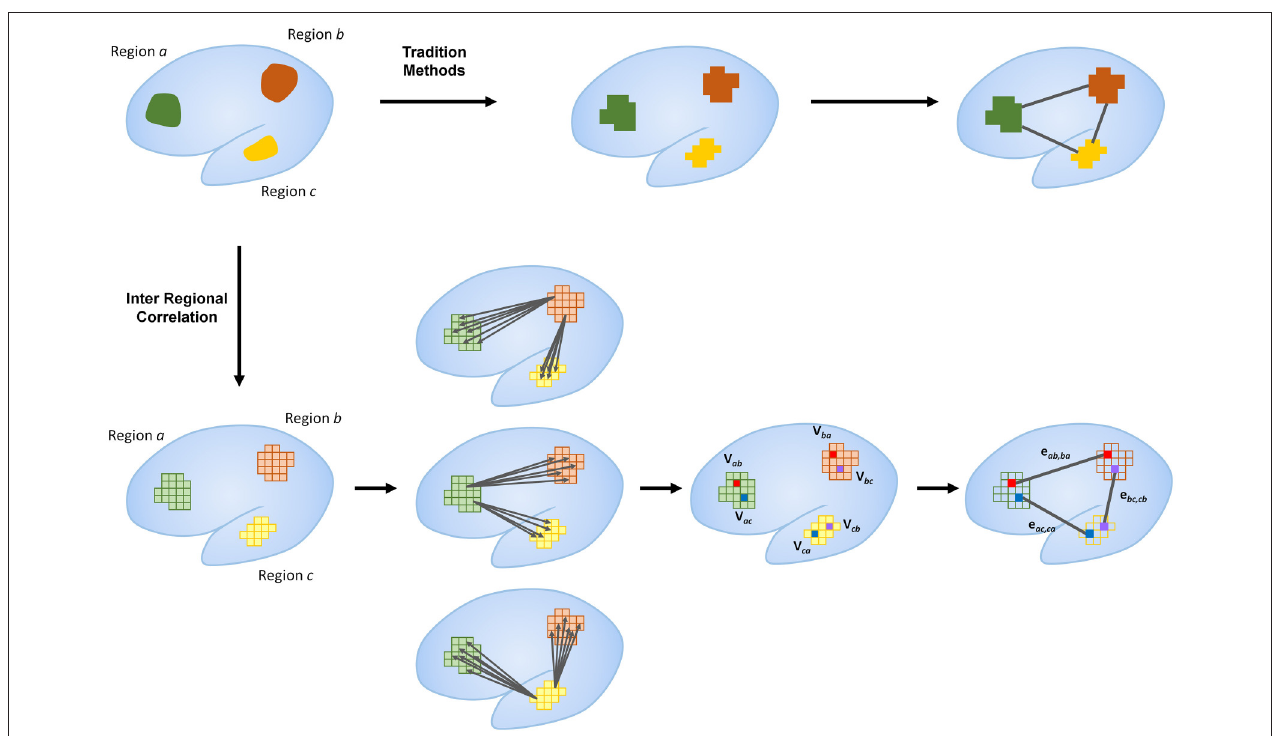
FIGURE 1 | Outline of proposed method compared to traditional methods. Traditional methods typically use large regions as nodes for network analysis. Regional correlation identifies specific nodes within each region that represent relative hubs to other regions in the same network. This is calculated by the identification of the voxel in a given region with the highest correlation to another region. Identification of these hub voxels as nodes within each network region allows for more detailed representations of network connectivity. The current figure shows only primary connectivity. Further breakdown of connectivity measures are outlined in Figure 2